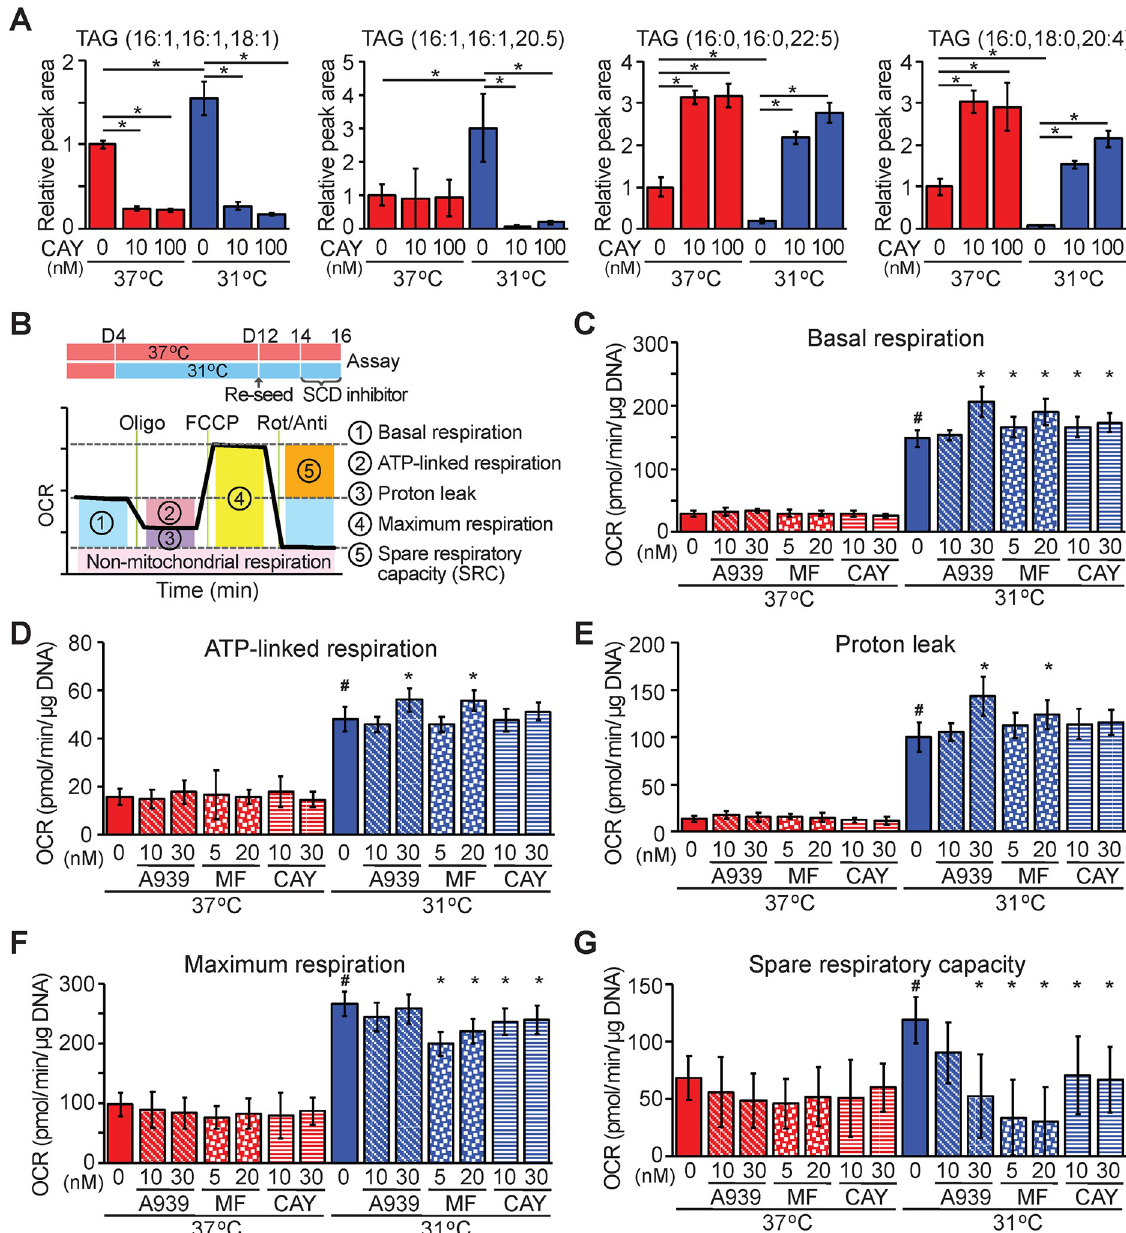
Fig 7. SCD1 activity is required for adipocytes to increase maximal OCR and spare respiratory capacity during adaptation to cool temperature. ( A ) CAY10566 decreases TAG containing monounsaturated lipids (left panels) and increases TAG containing saturated lipids (right panels). Adipocytes were cultured at 37˚C or 31˚C for 10 days with indicated concentrations of CAY10566. Peak area of each lipid is expressed as fold change relative to 37˚C control ( n = 4). Data are presented as mean ± SD. � p < 0.05. ( B – G )Differentiated adipocytes cultured at either 37˚C or 31˚C for 8 days were trypsinized, and adipocytes were isolated by centrifugation. Adipocytes were seeded on Cell- Tak coated Seahorse XF96 microplates, then cultured overnight upside down at either 37˚C or 31˚C. Adipocytes were cultured with SCD inhibitors: A-939572, MF-438, or CAY10566 at the indicated temperature for 2 days before assay ( n = 8–16 per group). ( B ) Summary of metabolic variables estimated. ( C ) Basal respiration. ( D ) ATP-linked respiration. ( E ) Proton leak. ( F ) Maximal respiration. ( G ) Spare respiratory capacity. Values are mean ± SD. � is significantly different from vehicle control. # indicates a difference from 37˚C vehicle control. Data shown are representative of at least 3 independent experiments. Numerical data for all graphs are provided in S7 Data. FCCP, carbonyl cyanide- p -trifluoromethoxyphenylhydrazone; OCR, oxygen consumption rate; Oligo, oligomycin; Rot/Anti, rotenone and antimycin; SCD1, stearoyl-CoA desaturase-1; SRC, spare respiratory capacity; TAG, triacylglycerol.